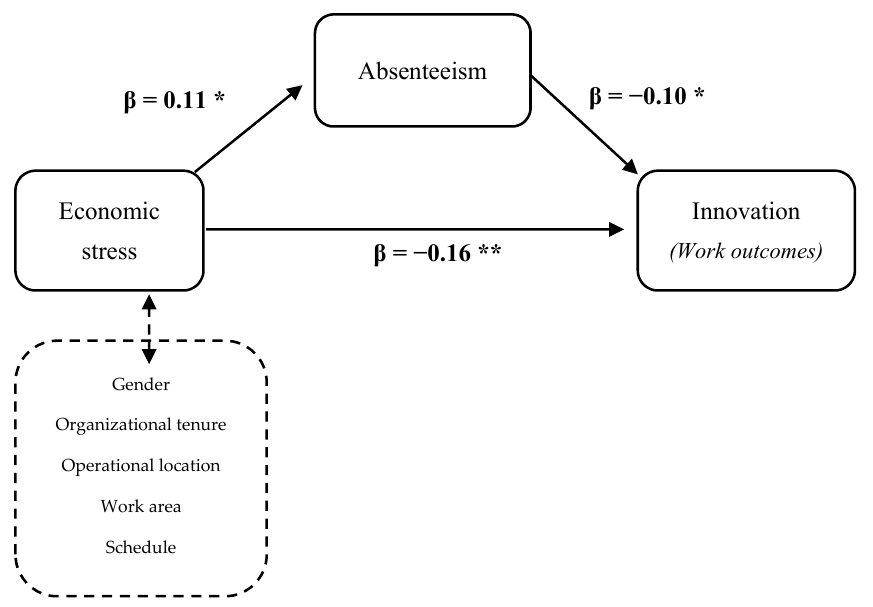
Figure 2. Mediation Model and relationship between variables. The path weights in the graph were standardized. ** p < 0.01. * p < 0.05.